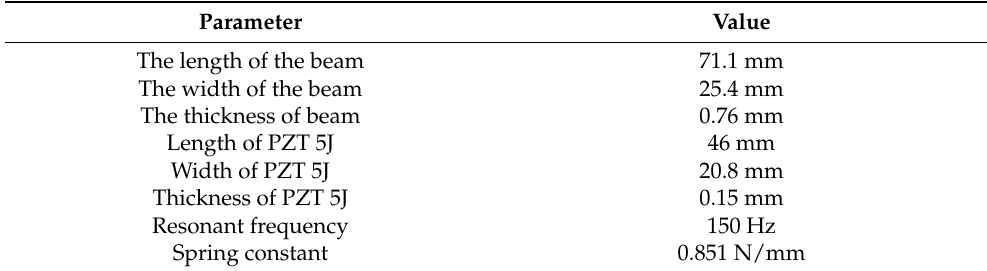
Table 1. Parameters of the beam structure and piezoelectric elements (PZT 5J S230-J1FR-1808XB, Mide Technology Co., Woburn, MA, USA).